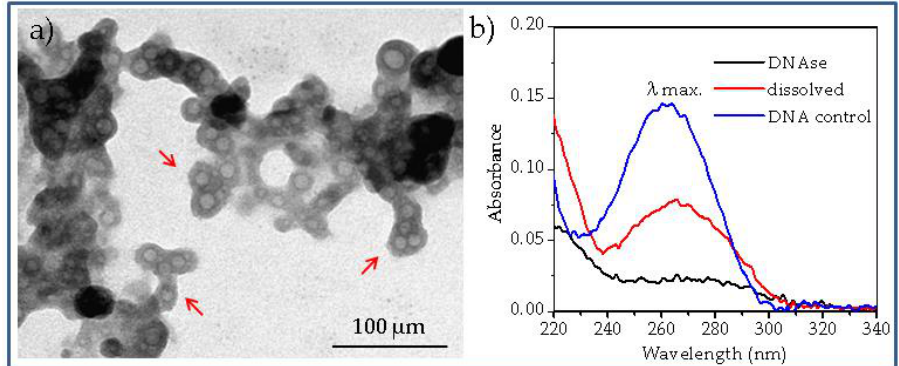
Figure 11. ( a ) TEM micrograph showing HAp-DNA nanocapsules. Red arrows point out capsules with a clearly distinctive contrast indicative of the encapsulated DNA in their inner part; ( b ) UV-vis absorption spectra of the aqueous solution/dispersion of HAp-DNA nanocrystals, sample digested with deoxyribonuclease to eliminate adsorbed DNA (black trace), corresponding samples after being dissolved in an acid medium (red trace), and DNA in aqueous solution (blue trace). Reproduced with permission from [126], Royal Society of Chemistry, 2013.